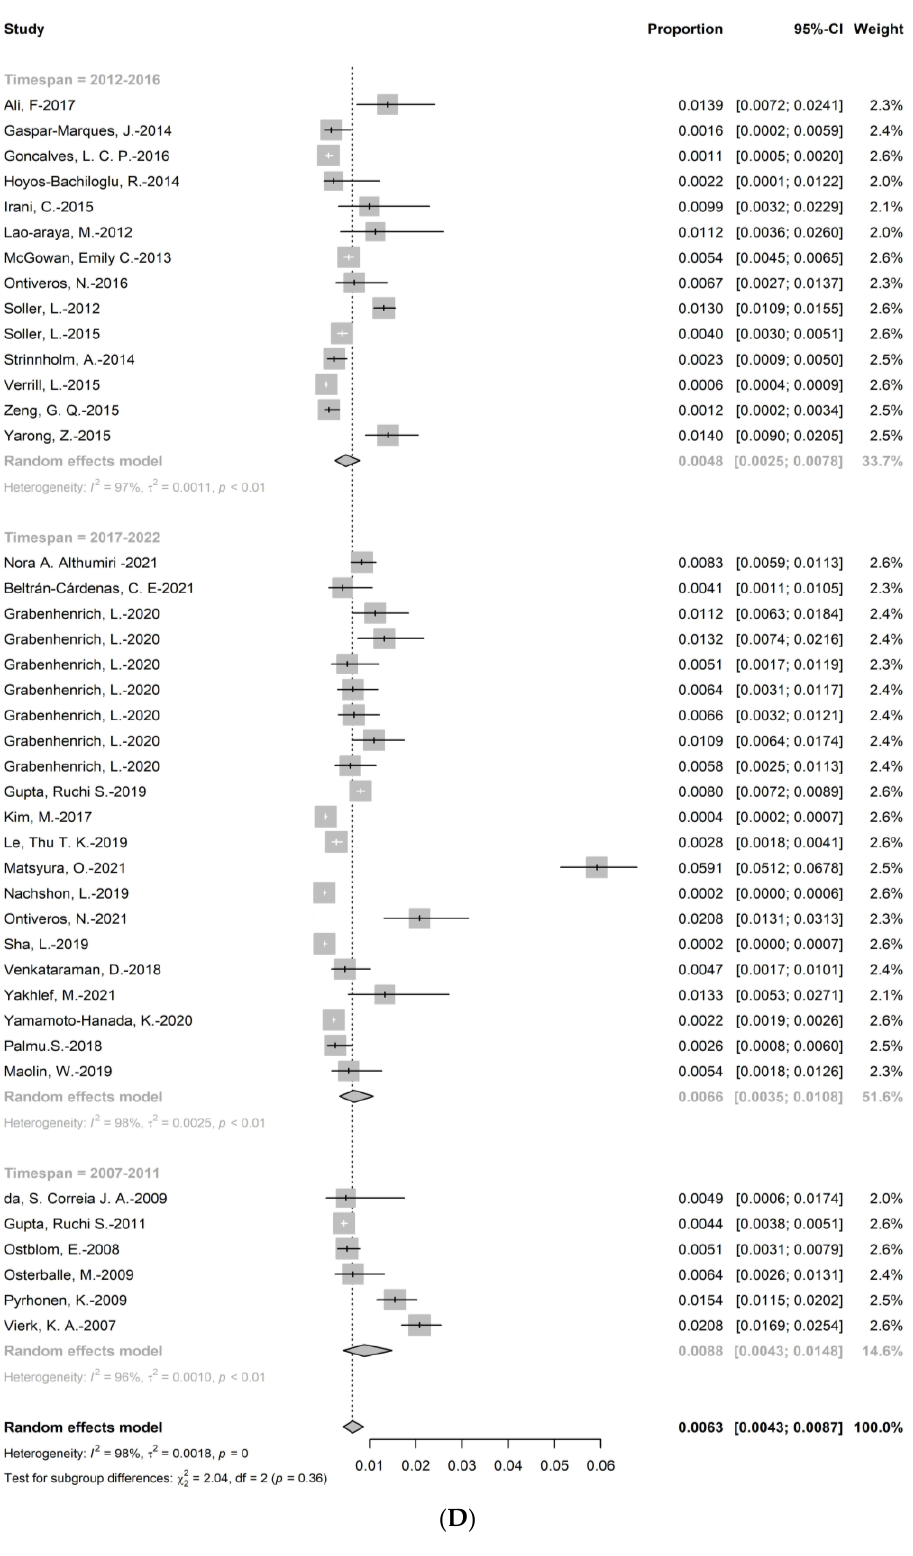
Figure 2. The prevalence of self-reported wheat allergy; ( A ): the subgroup analysis for age; ( B ): the subgroup analysis for economy; ( C ): the subgroup analysis for region, ( D ): the subgroup analysis for timespan [18,19,21,23,26–28,30–32,34–37,41,42,44,46,47,49–51,54–57,59,62,63,66–68,70–72].